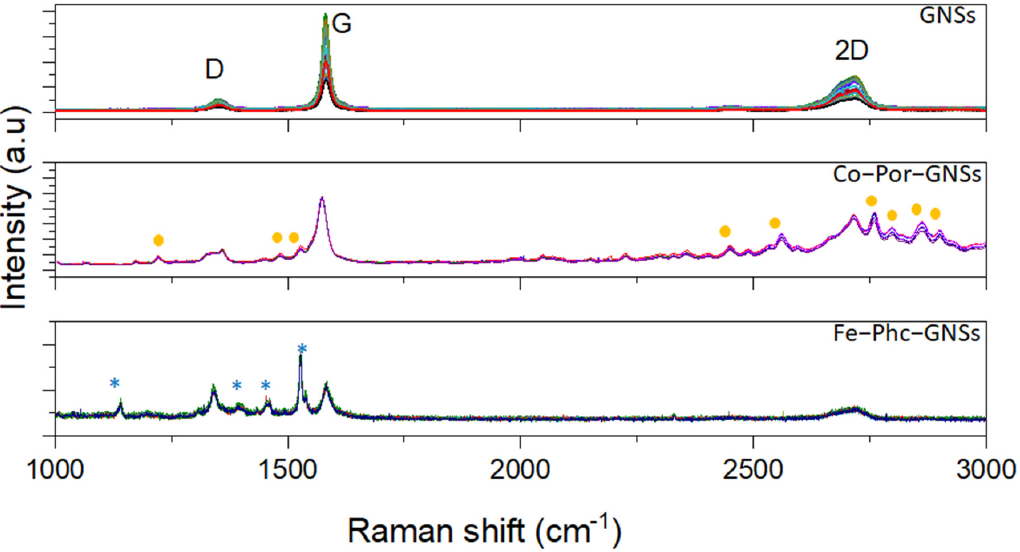
Figure 1. Raman spectra of (top to bottom) solution-processed graphene nanosheets (GNSs), Co-Por-GNSs, and Fe-Phc-GNSs ( λ exc = 532 nm).